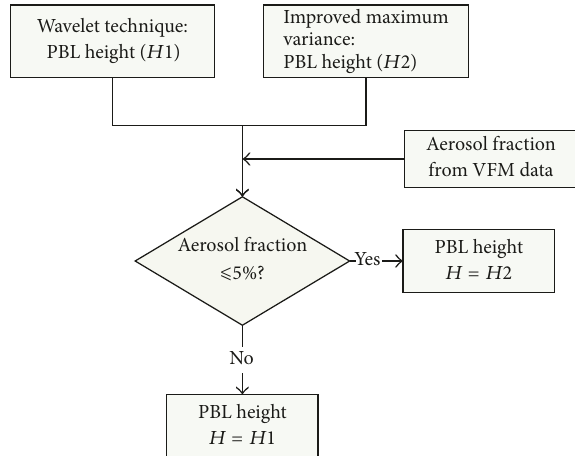
Figure 4: The flowchart of the integrated